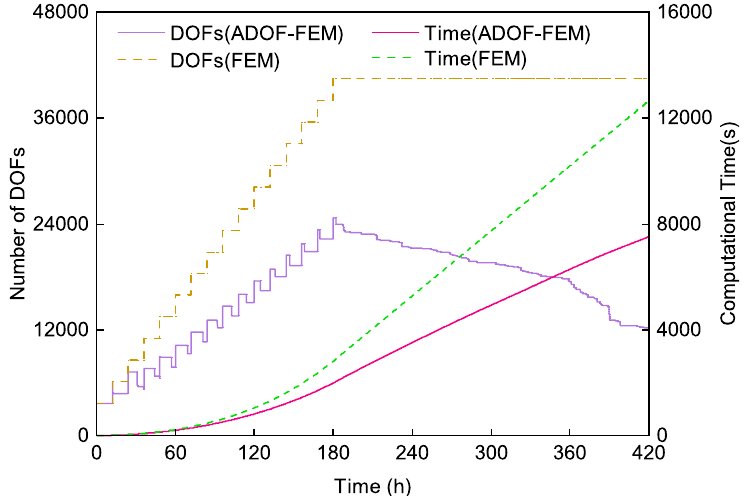
Figure 15. The change of the number of DOFs and computational time in Example